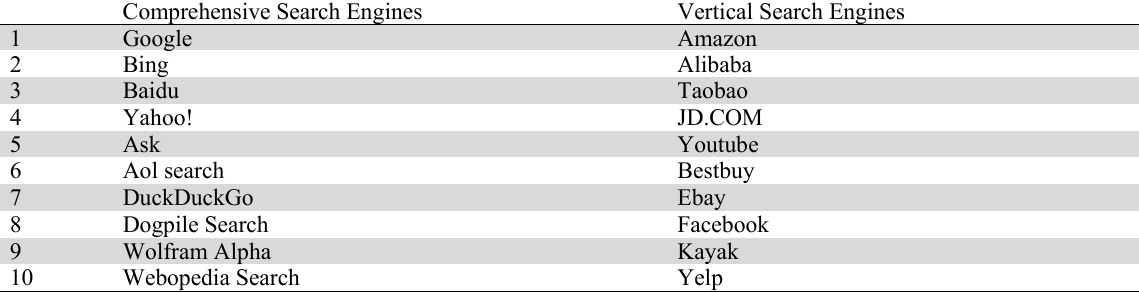
Different SEs of Comprehensive and Vertical